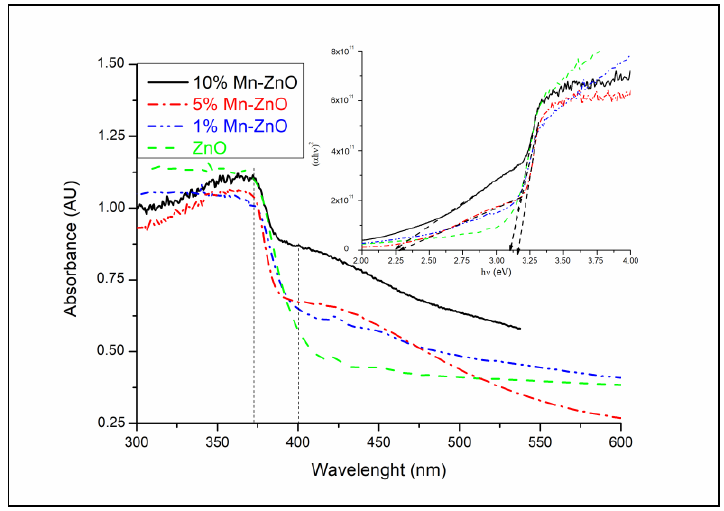
Figure 3. UV-vis diffuse reflectance spectra and Tauc’s plots (figure inset) of x%Mn-ZnO nanomaterials.